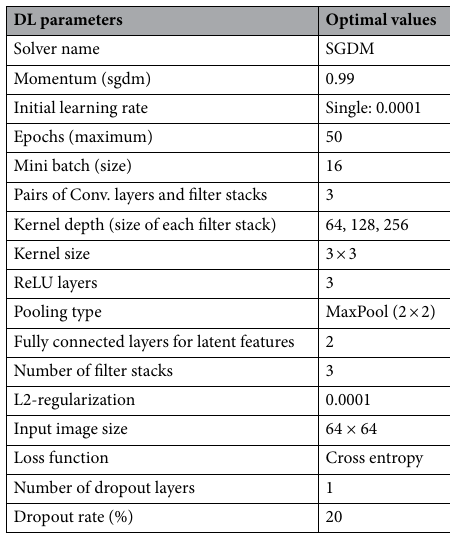
Table 10. Deep learning parameters used for latent features extraction using DLRFE module.